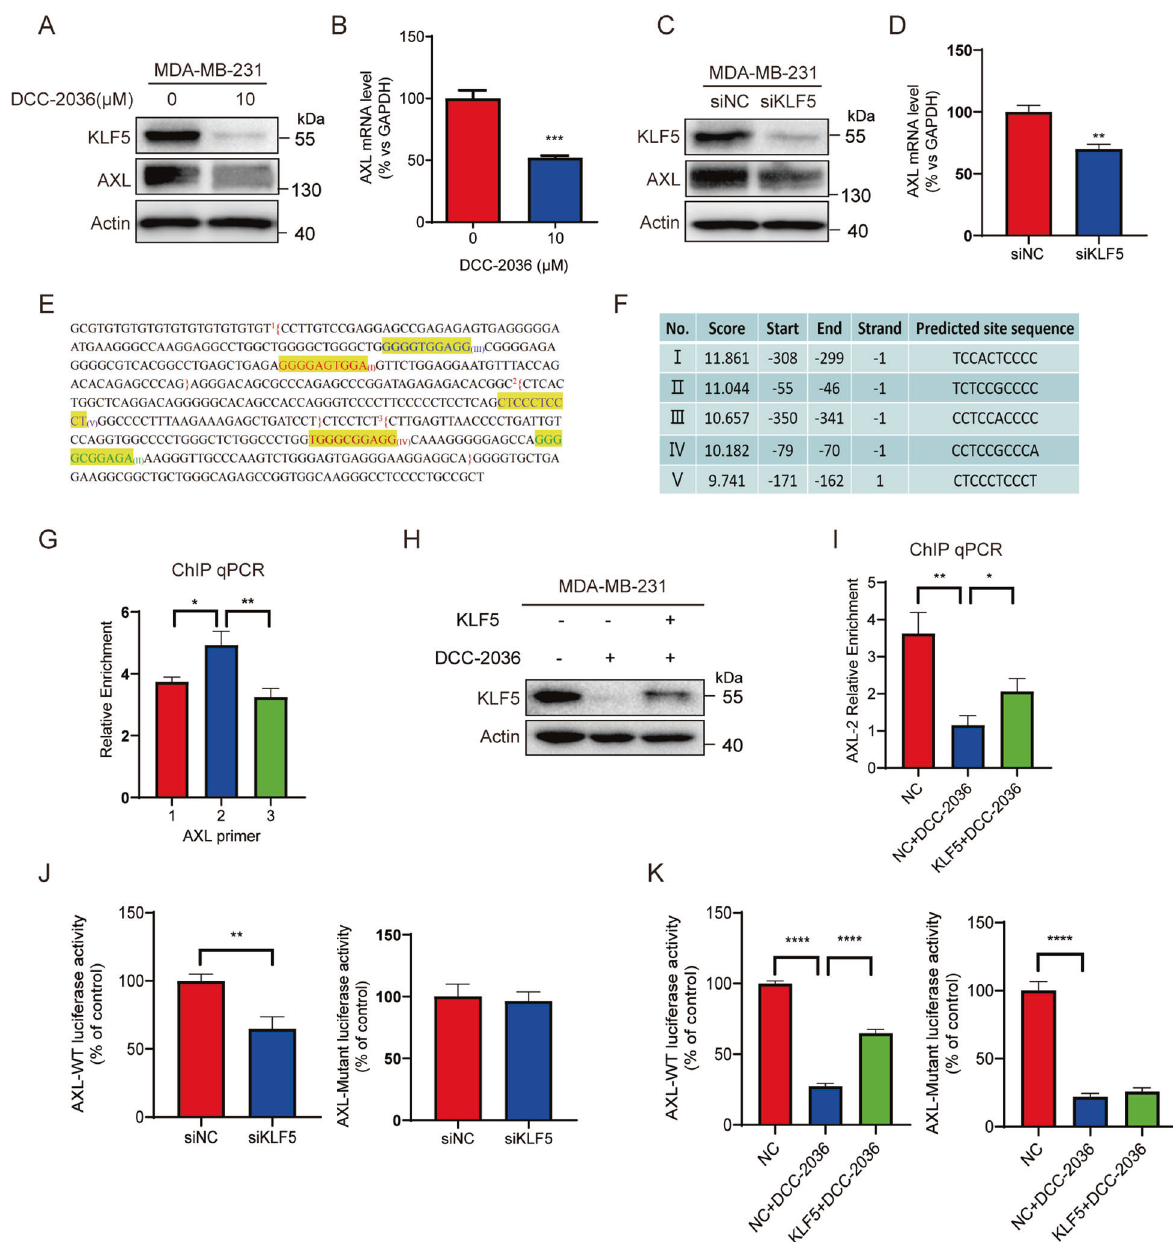
Fig. 5 KLF5 upregulates AXL expression via binding to the promoter of AXL . A , B DCC-2036 downregulated the protein level and mRNA level of AXL . After the MDA-MB-231 cells were treated with DCC-2036 at 10 μ M for 48 h, the protein and mRNA levels of AXL were measured by Western Blotting and qPCR. C , D Knockdown of KLF5 decreased the protein level and mRNA level of AXL . MDA-MB-231 cells were transfected with siKLF5 or control siRNA (siNC) for 48 h, followed by WB and qPCR. E Schematic representation of AXL promoter. I – V represented the putative site in the AXL promoter predicted by the Jasper database. One to three represented the qPCR products (fragments) by different AXL primers. F The information of the fi ve highest-scoring putative sites (I – V). G Chromatin immunoprecipitation (ChIP) assay indicated that KLF5 is directly bound to AXL promoter mainly at fragment 2 in MDA-MB-231 cells. The results were shown as relative enrichment compared with IgG. H , I overexpression of KLF5 in MDA-MB-231 cells partially but signi fi cantly rescued the DCC-2036-induced reduction of KLF5 binding to fragment 2. MDA-MB-231 cells were transfected with KLF5 or vector control plasmid, followed by treating with 10 μ M DCC-2036 for 48 h before WB and ChIP qPCR assay. J Regulation of AXL promoter activity by KLF5 in MDA-MB-231 cells. Wild-type ( − 2000 to + 50 bp) or mutant promoter (site V was deleted) was cotransfected with siNC or siKLF5 , and luciferase activity was measured with pRL-TK as an internal control. Data represent the mean of three independent experiments ± s.d. K Regulation of AXL promoter activity by DCC-2036 and overexpression of KLF5 in MDA-MB-231 cells. Wild-type or mutant promoter was cotransfected with KLF5 or vector control plasmid, followed by treating with 10 μ M DCC-2036 for 48 h, and then luciferase activity was measured. Immunoblotting showed that DCC-2036 dramatically attenuates treatment obviously decreased tumor weights (Fig. 7D) and p-AXL, AXL, and KLF5 expression (Fig. 7G – I). Those results volumes (Fig. 7E) of 4T1 tumor-bearing mice and exhibited longer indicated that DCC-2036 showed a suppressive effect on CSCs tumor-free survival (Figs. 7F, 2 × 10 5 group). Moreover, compared in vivo. with the control group, Immunohistochemical analysis and Cell Death and Disease (2022)